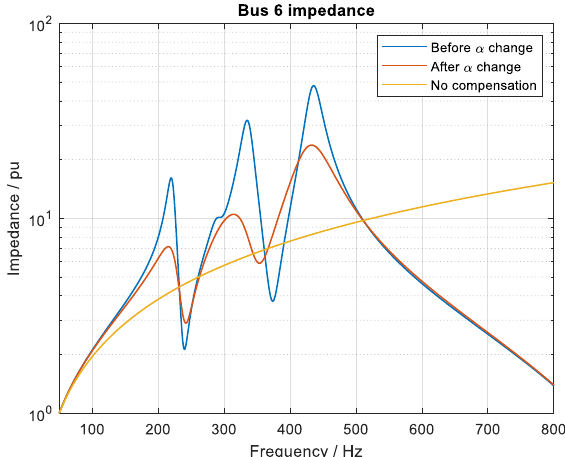
Figure 8. Bus 6 impedance change.